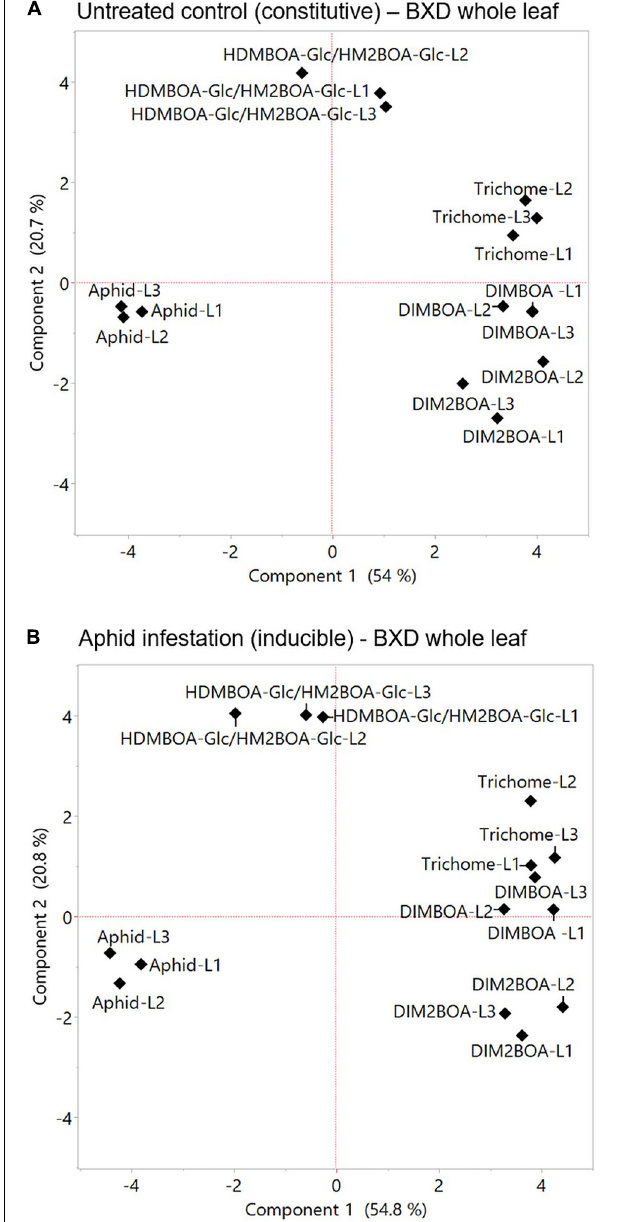
FIGURE 7 | Principal component analysis plots of plants’ physical and chemical defense parameters measured at the whole leaf level. The relation between trichome density, BXDs of the three leaves (leaf-1 [L1], leaf-2 [L2], and leaf-3 [L3]) under untreated control (A) , and aphid infestation (B) on aphid reproduction. The data for the aphid bioassay, trichomes, and BXDs were normalized to log2 transformation for the projection of PCA. The accessions that were tested in this analysis are TD-728, TD-805, TD-1059, TD-1405, TD-1855, TD-2056, TD-2390, TD-3115, and Svevo, the domesticated durum